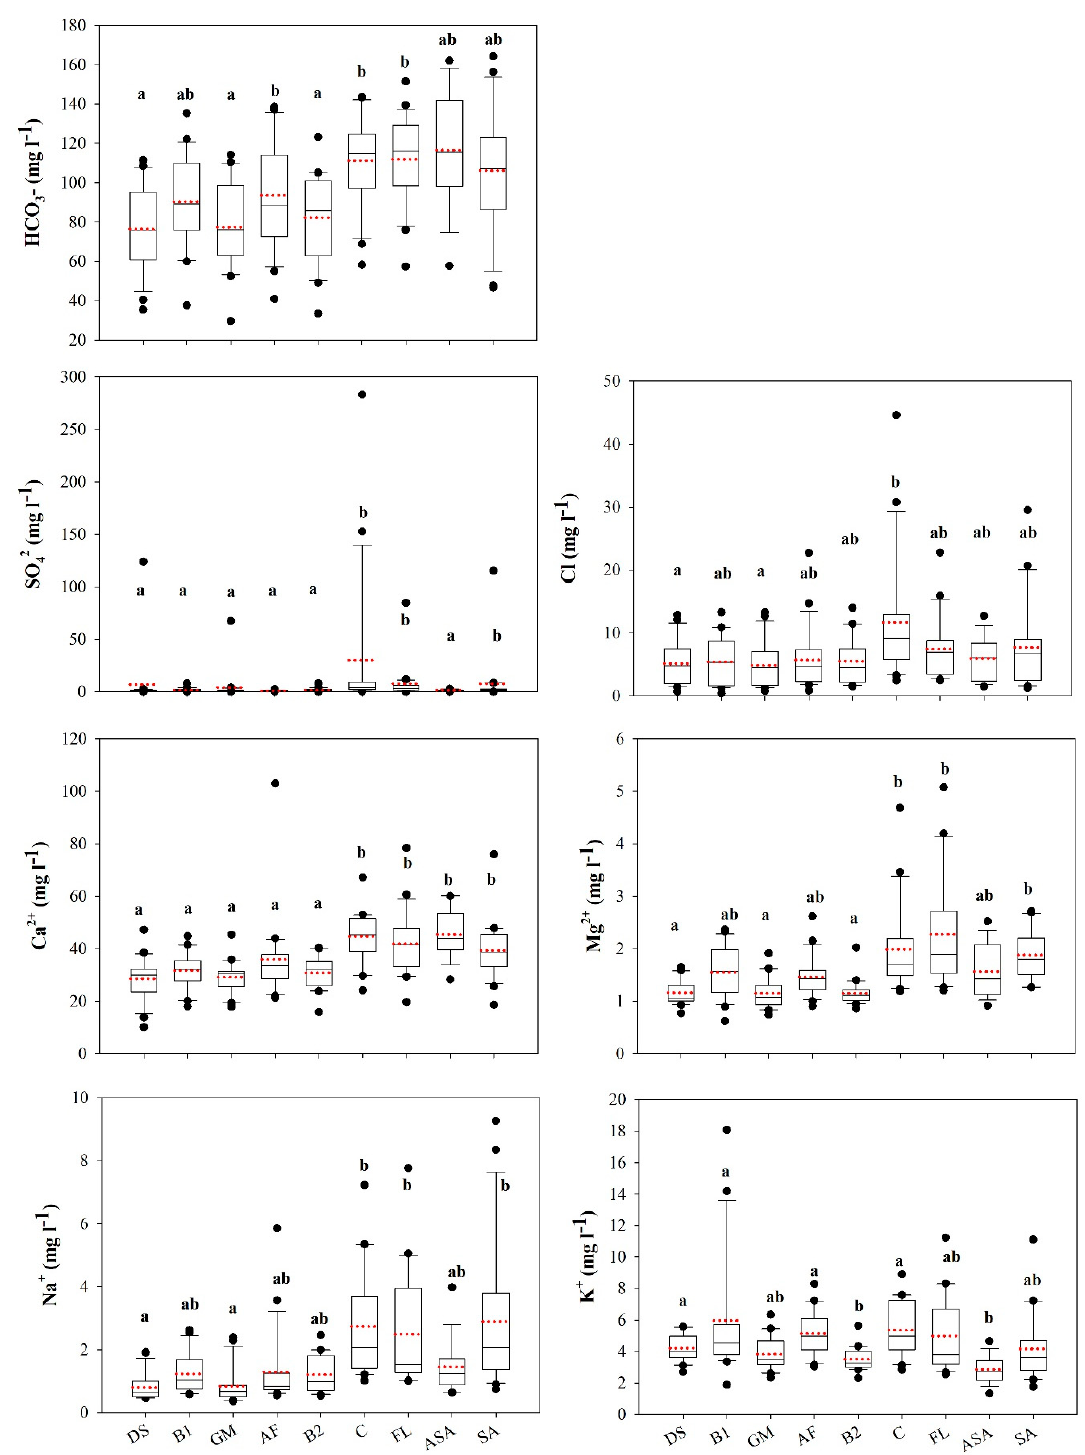
Figure 3. Solute concentrations (mg L − 1 ) from various land uses for the period 1991–2011 (red dotted line: mean value; black line: median values; black points: outliers; borders of the box are 25 and 75 percentiles; and borders of the box plot are the 10 and 90 percentiles). DS: Dense shrub cover; B1: burned plot 1; GM: grazing meadows; AF: abandoned field; B2: burned plot 2; C: Cereal; FL: fallow land; ASA: abandoned shifting agriculture; AS: active shifting. Means with the different lower-case letter within are significantly different at the 0.05 level of significance (p < 0.05).